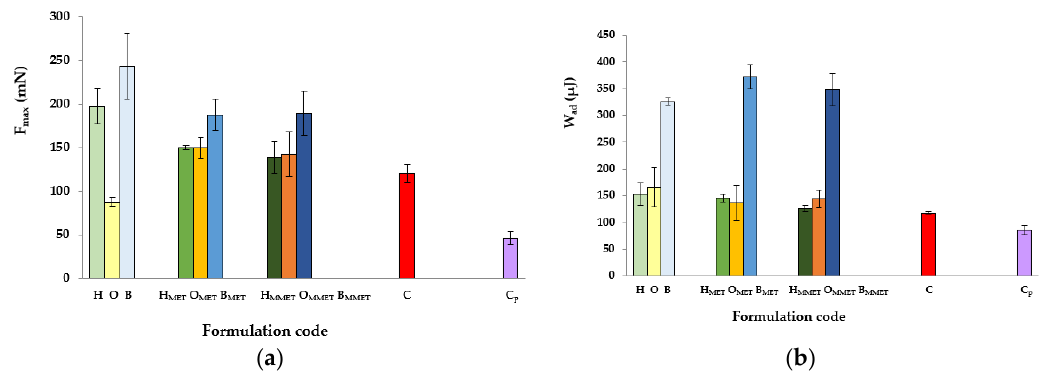
Figure 4. Ex vivo bioadhesive properties of hydrogels, oleogels and bigels containing MET (HMET, OMET, BMET) or MMET (HMMET, OMMET, BMMET), placebo gels (H, O, B) and controls; commercially available product (C) and cellulose paper (C p ) determined as the maximum detachment force F max ( a ) and the work of adhesion W ad ( b ).